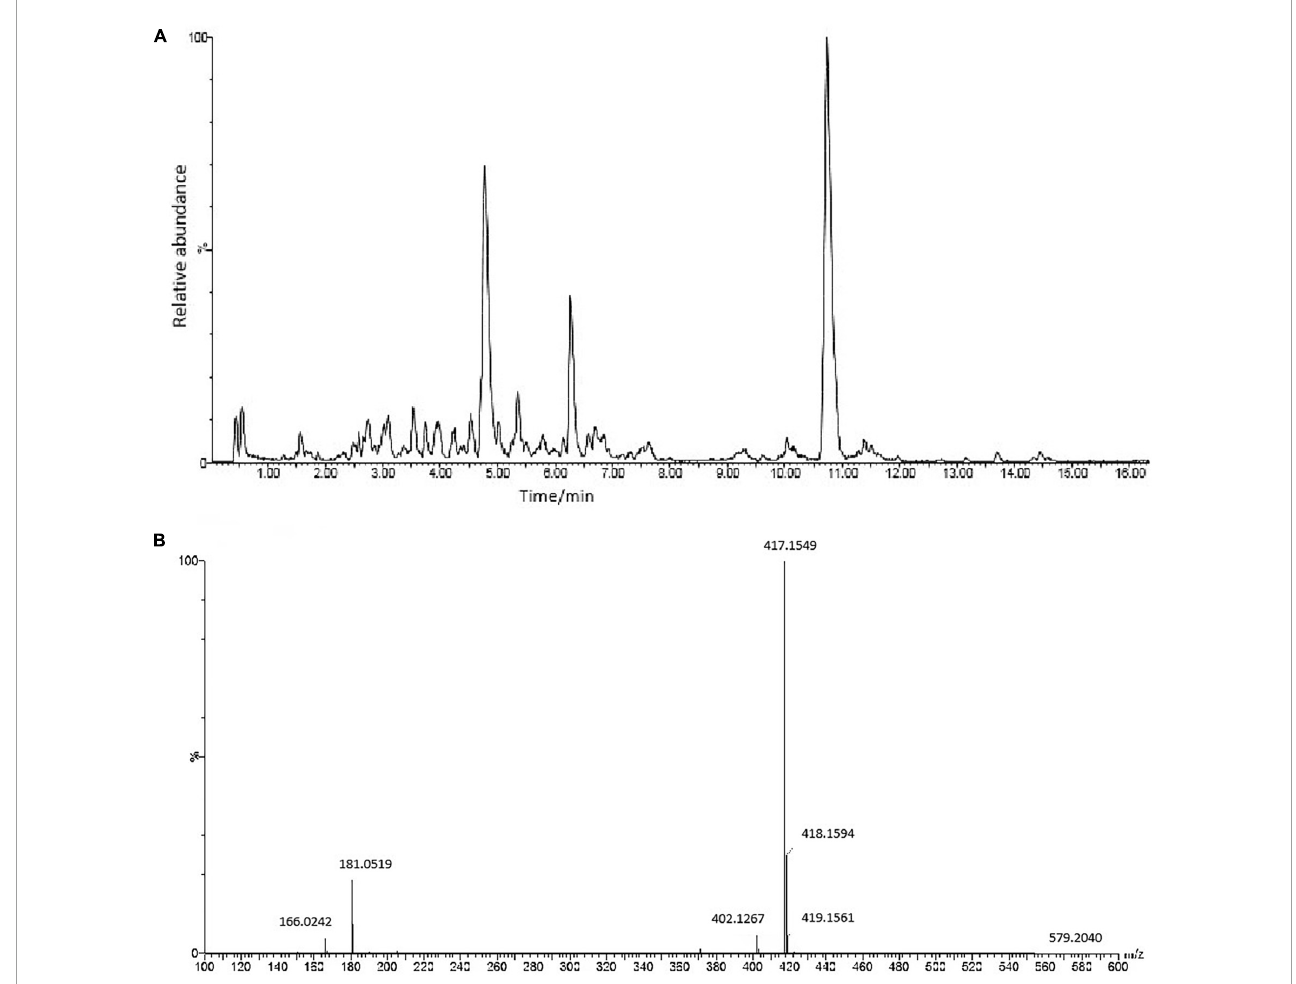
FIGURE1 (A) The chemical composition of ASE identified by UPLC-ESI-Q-TOF-MS/MS analysis in negative ion mode. (B) MS/MS spectrum of Syringaresinol-4-O- β